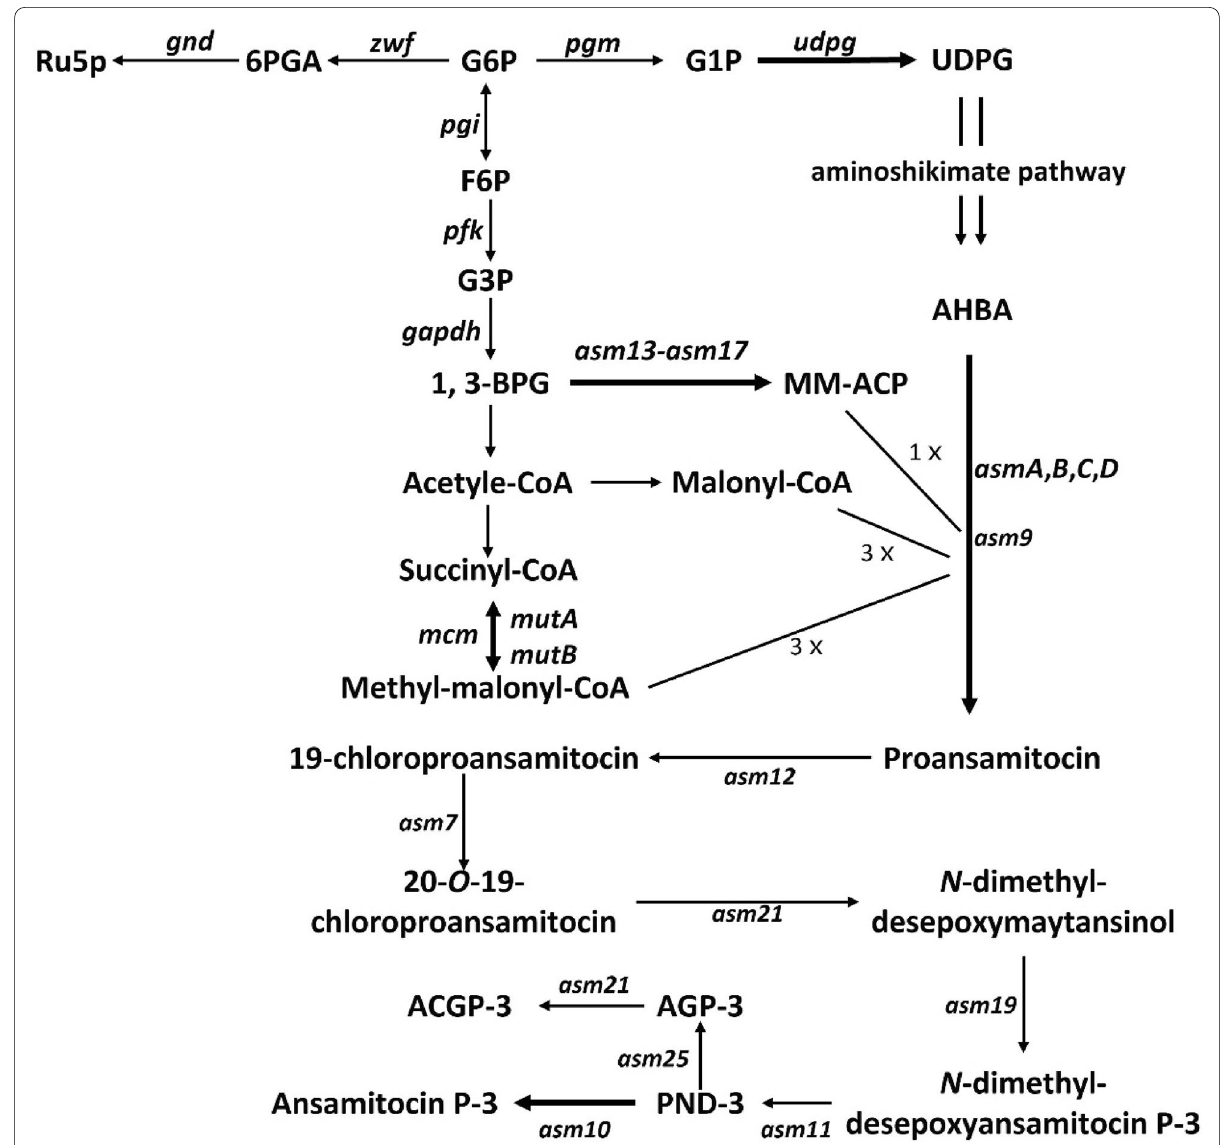
Fig. 1 The general pathway map of AP-3 biosynthesis. Ru5p ribose 5-phosphate; 6PGA 6-phosphogluconic acid; G6P glucose-6-phosphate; G1P glucose 1-phosphate; UDPG uridine diphosphate glucose; F6P fructose-6-phosphate; G3P glyceraldehyde 3-phosphate; 1,3-BPG 1,3-bisphosphoglycerate; MM-ACP methoxymalonyl-ACP; AHBA 3-amino-5-hydroxybenzoic acid; PND-3 N -demethylansamitocin P-3; ACGP-3 4 ″ - O -carbamoylansamitocinoside P-3; AGP-3 ansamitocinoside